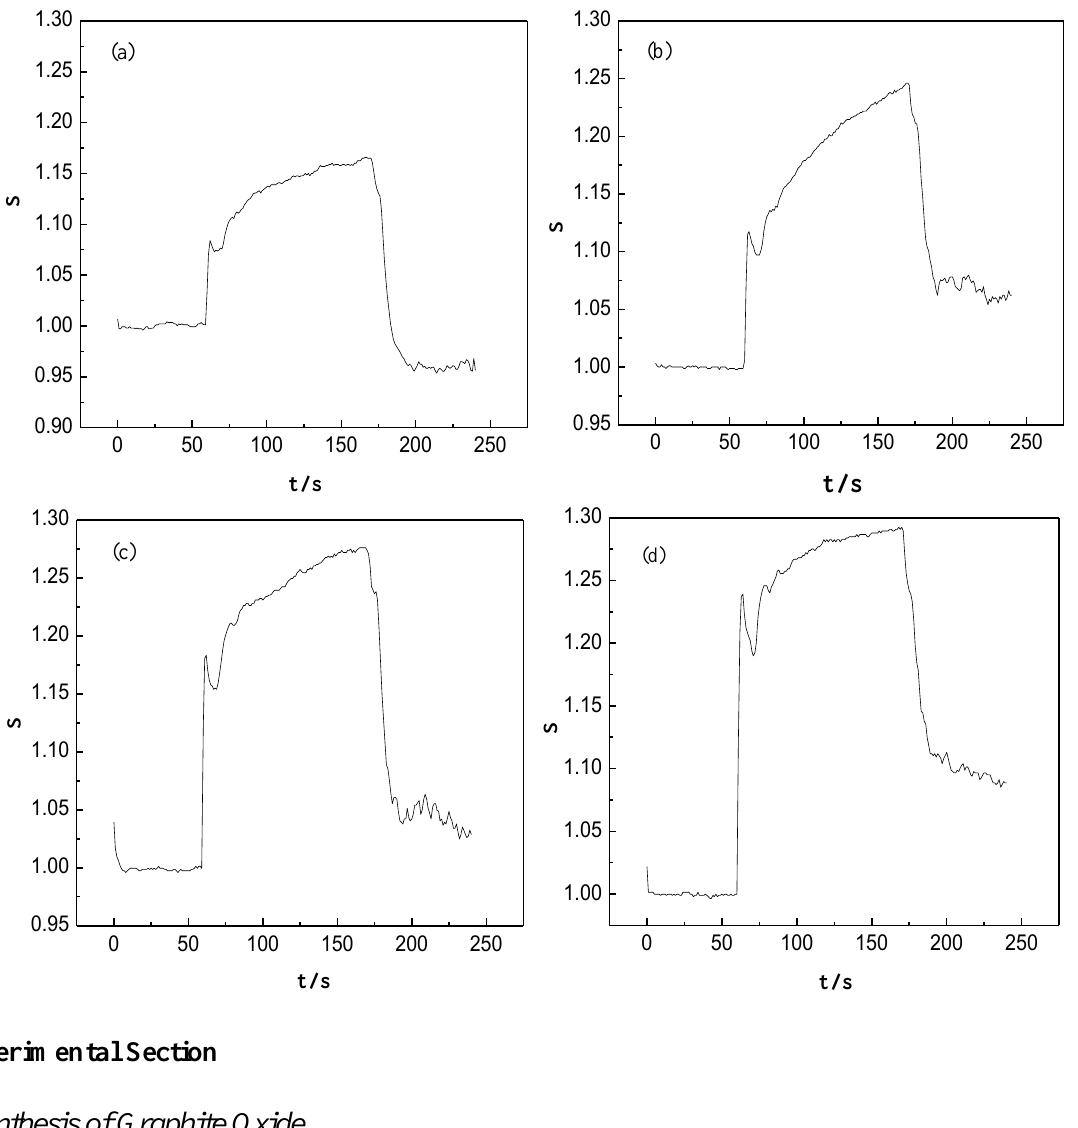
Figure 11. Responses of ( a ) FG, ( b ) FG (5%)/WO nanocomposites and ( d ) FG (2%)/WO voltage of 2.45